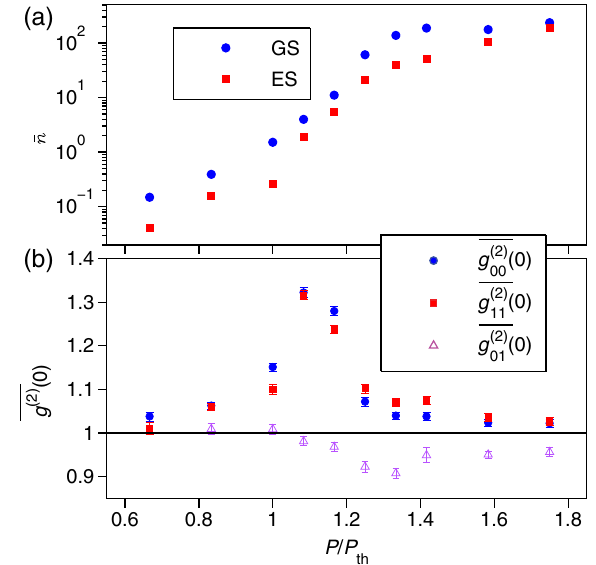
ffiffiffiffiffi p n . s FIG. 4. Second-order correlations of the two-mode polariton laser. (a) The occupation numbers of the ground state (dots) and the excited state (squares) vs P=P excited state. (b) g ð 2 Þ ð 0 Þ vs P=P ð 2 Þ ð 0 Þ : autocorrelation of ES; and g ð 2 Þ g 11 between GS and